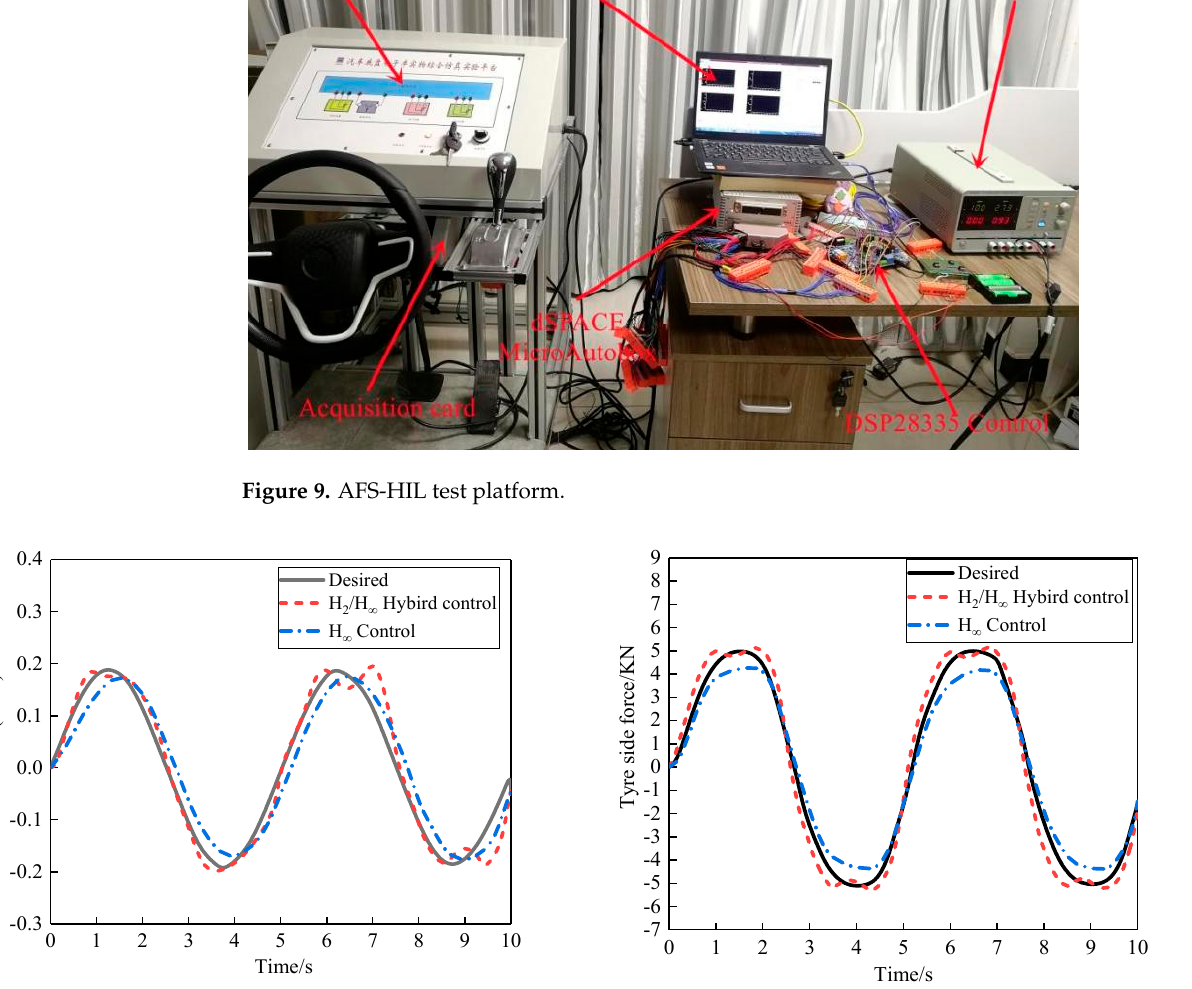
x is 20 m/s, and µ is 0.4). ( a ) Yaw rate; ( b ) tire side